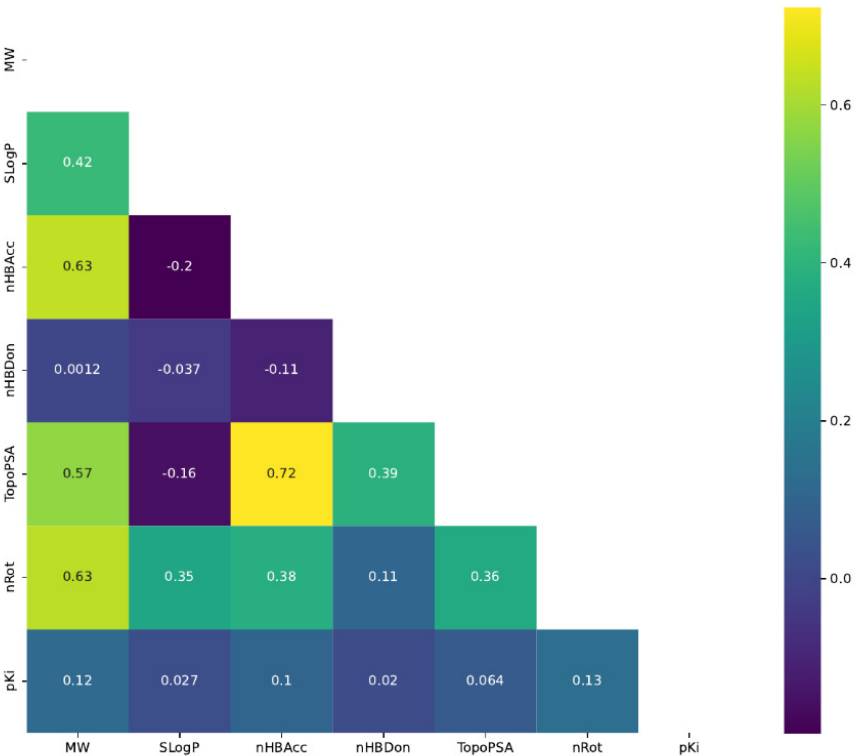
Figure 8. Correlation matrix of six chemical descriptors and pKi. Pearson correlation coefficients are displayed on the heatmap. MW, molecular weight; nHBDon, number of H-bond donors; SLogP, n -octanol/water partition coefficient; nHBAcc, number of H-bond acceptors; TopoPSA, polar surface area; nRot, number of rotatable bonds; pKi, affinity value for 5-HT1A serotonin receptor.